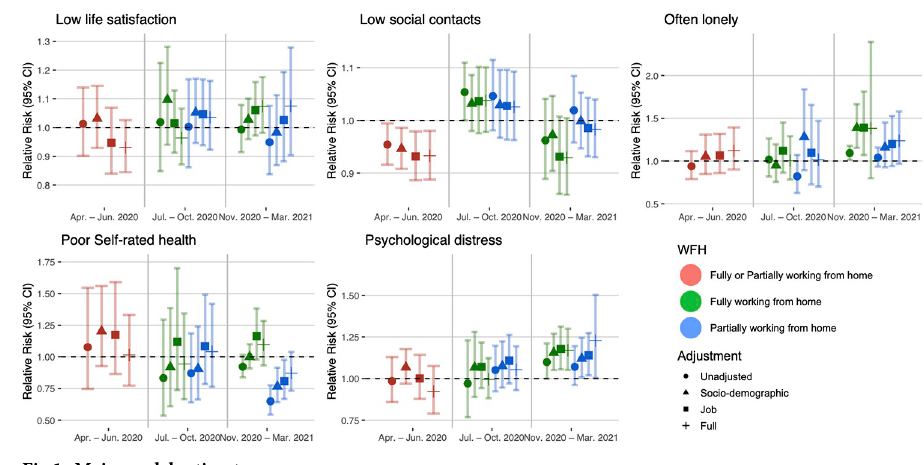
Fig 1. Main model